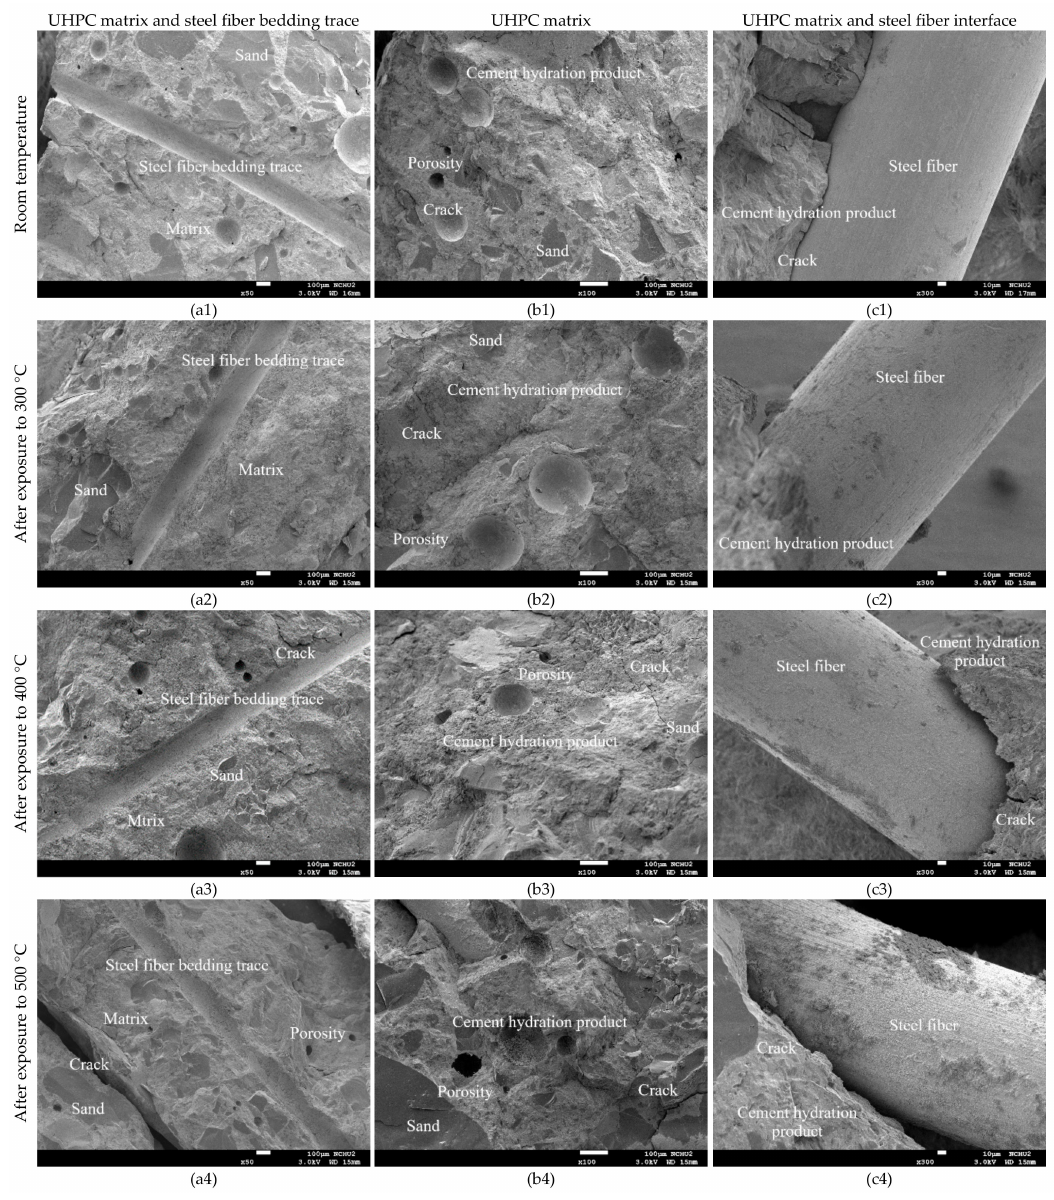
Figure 13. Comparison of SEM observation before and after fire damage: ( a ) 50 × ( b ) 100 × , and ( c ) 300 ×